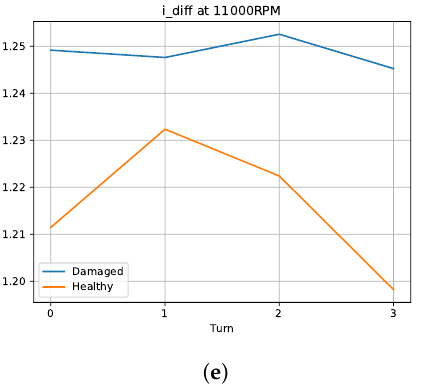
Figure 16. i dif f indicator at various speed for healthy and faulty motors. ( a ) i dif f —3000RPM; ( b ) i dif f —5000RPM; ( c ) i dif f —7000RPM; ( d ) i dif f —9000RPM; ( e ) i dif f